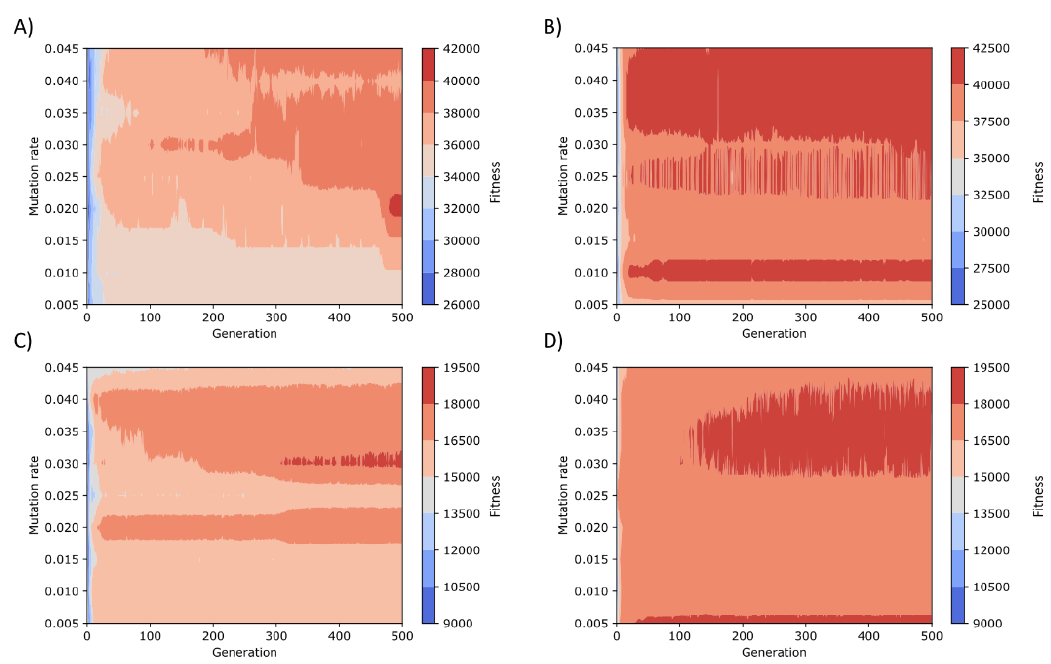
Figure 9. Screening for the search of the optimal combination of a mutation rate and number of generations values. Experiments conducted for the SGA ( A ) with antibiotic screening procedure and ( C ) screening based on the Lac operon. Experiments performed for the SMGA ( B ) with antibiotic screening procedure and ( D ) with the Lac operon screening method.